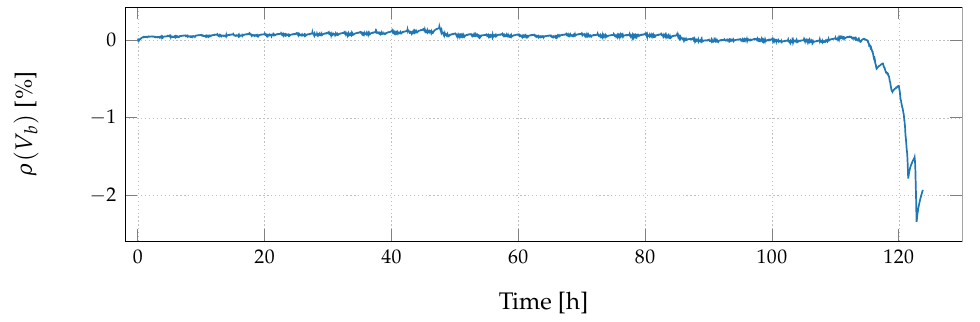
Figure 16. Performance of the model with a constant static aging factor on the random load evaluation